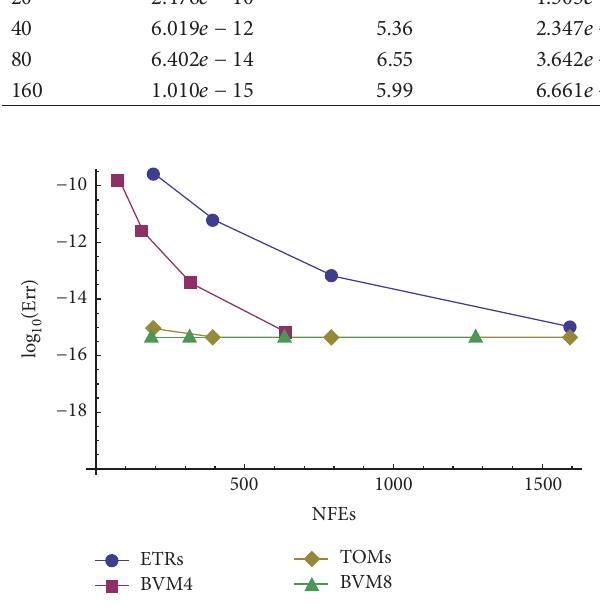
Figure 3: Efficiency curve for Example